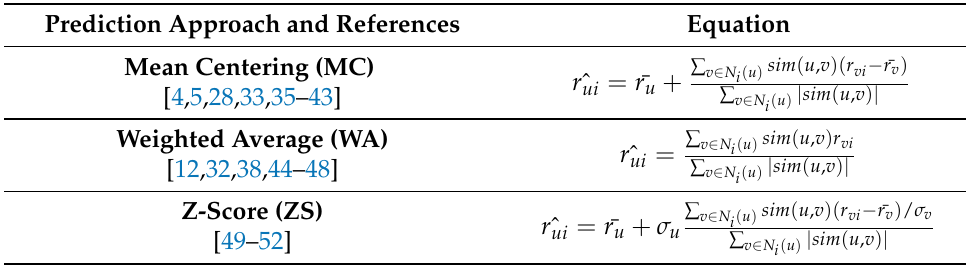
Table 4. Prediction Approach.